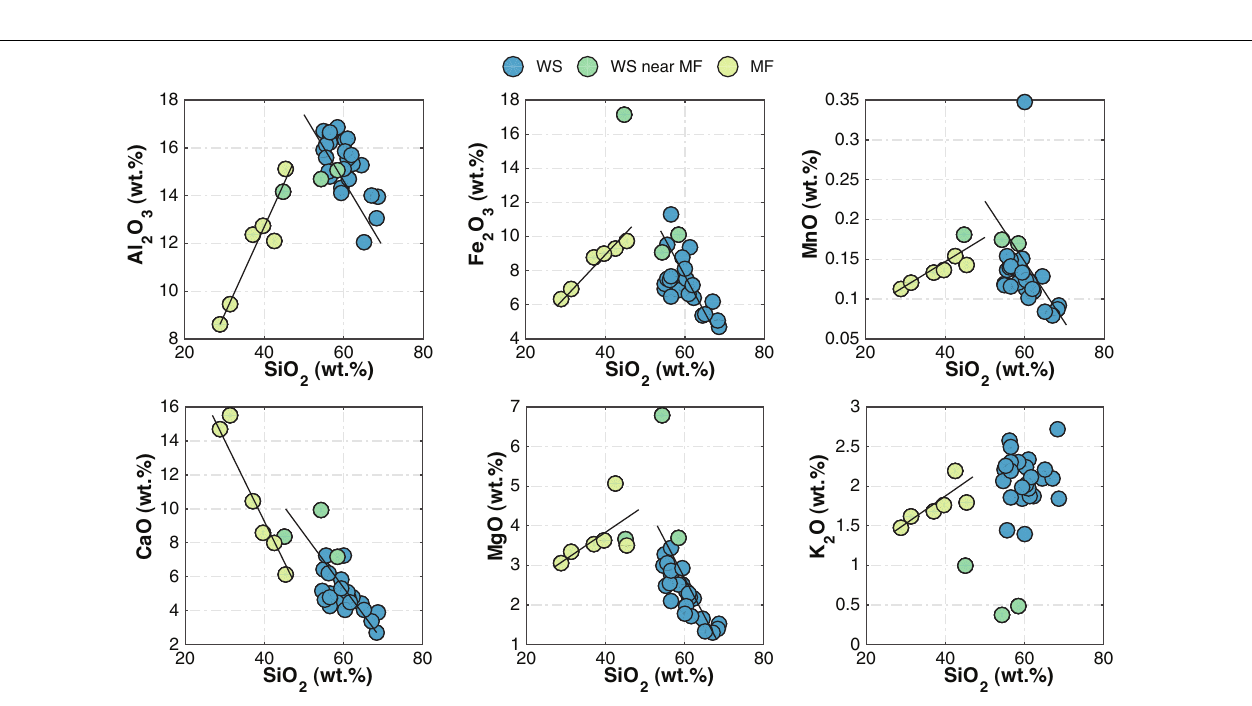
Frontiers in Earth Science |